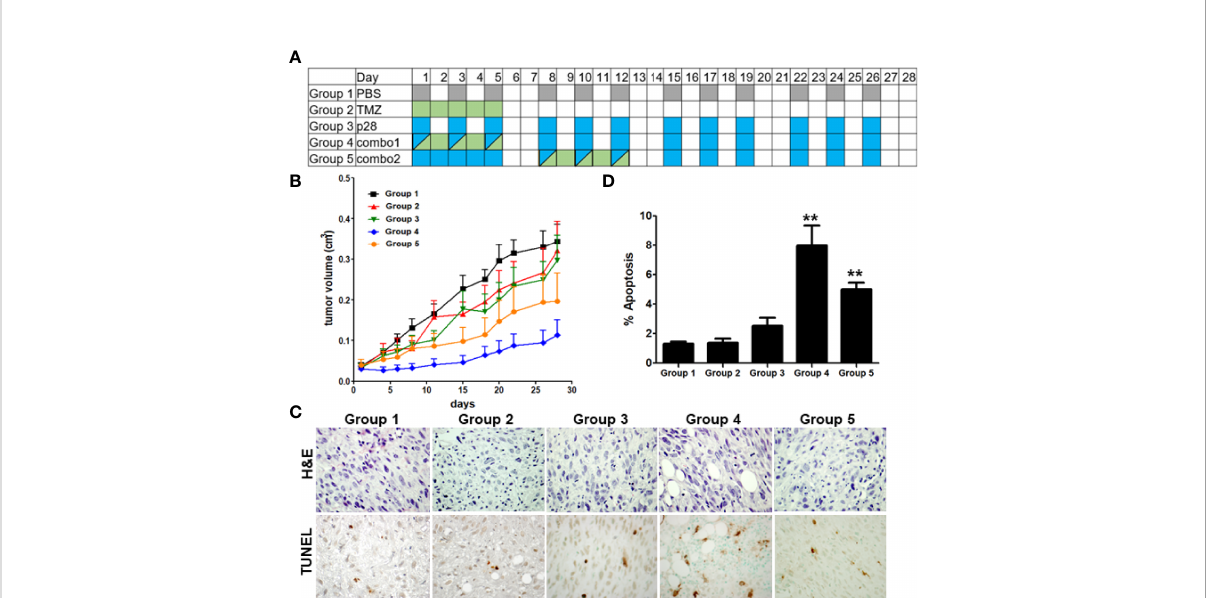
FIGURE 6 Improvement of the TMZ activity in combination with p28. (A), Treatment schedule of Groups 1-5. Athymic mice bearing human GBM U-118 cells were randomized into fi ve groups; PBS (control), TMZ 5 mg/kg (=25.7 m mol/kg), p28 10 mg/kg (=3.4 m mol/kg) i.p ., and combinations. (B), U-118 xenograft tumor growth curve. N=7/group, Mean+SD. (C). Formalin- fi xed tumor sections were stained with H&E and TUNEL (apoptosis). (D). TUNEL-positive cells were counted in each group. **P<0.01